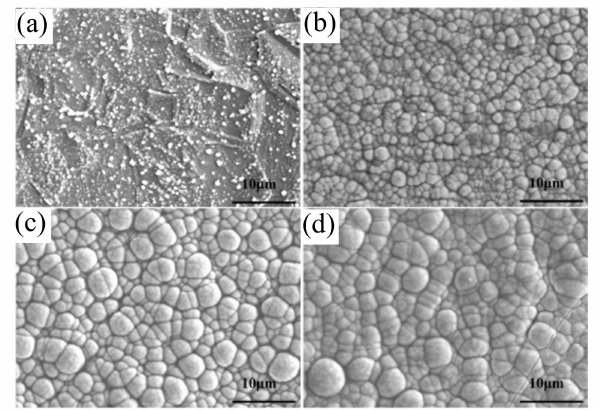
Figure 3. SEM images of the NiCrP alloy coatings at pH = 3.5, D K = 15 A / dm 2 and 100 g / L of CrCl 3 · 6H 2 O